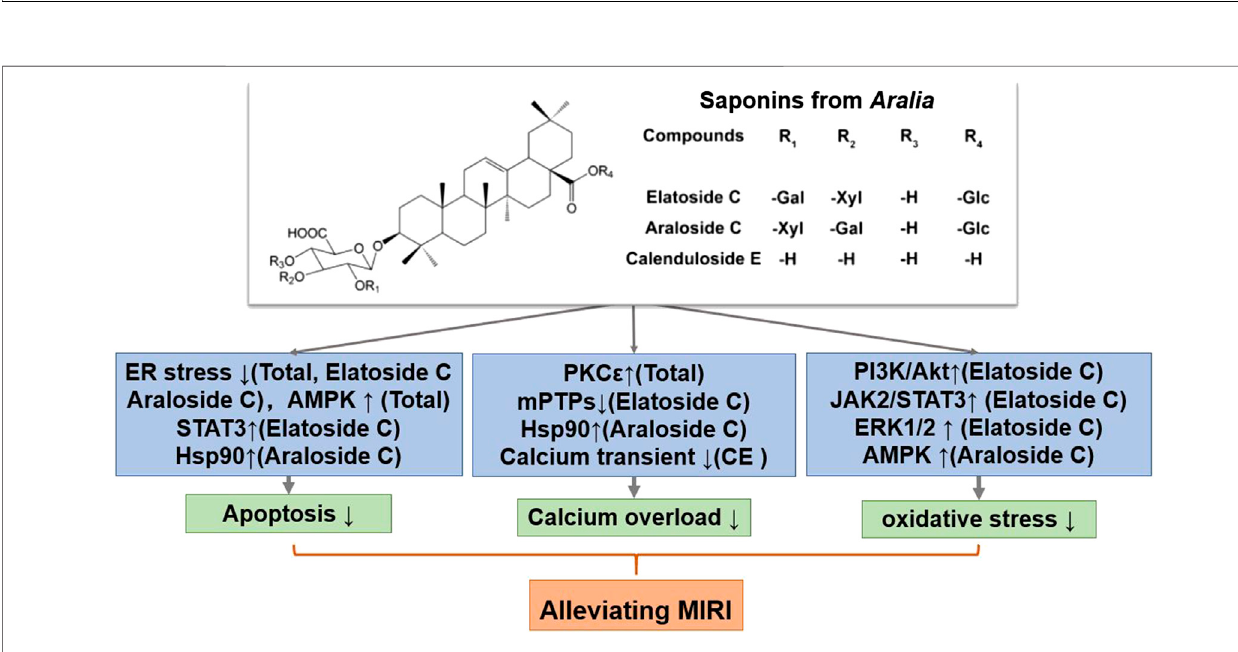
Frontiers in Pharmacology |